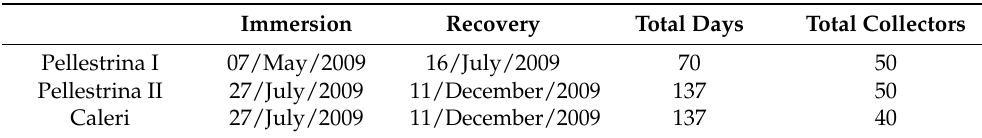
Table 1. Sampling design: duration of collectors’ immersion periods, and number of collectors used at each